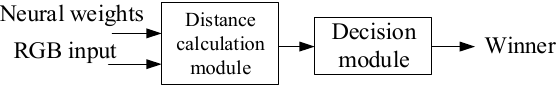
Figure 9. System architecture of the SOM color classification module.